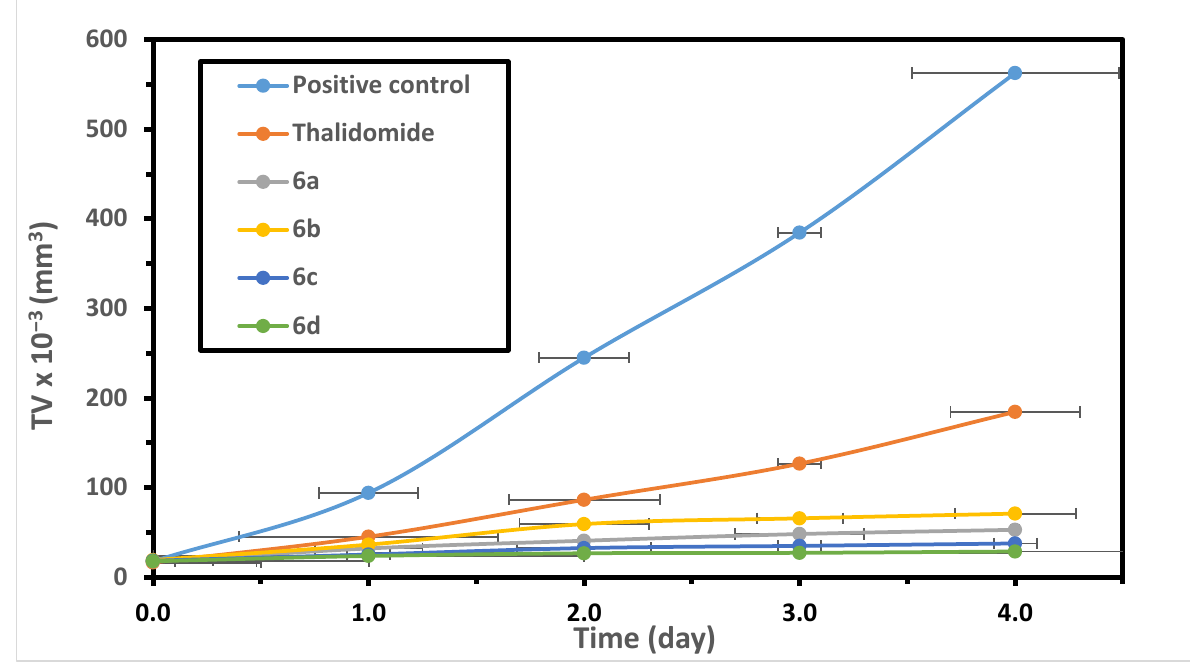
Figure 1. Effect of thalidomide and indoloquinoline analogs 6a , 6b , 6c and 6d on tumor volume changes of the six groups over the course of the treatment. Values expressed as means ± SD.